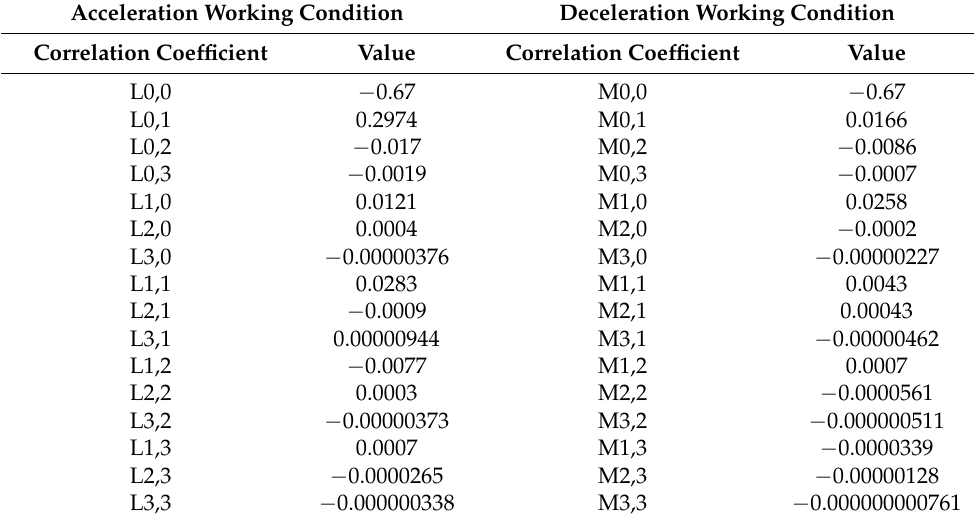
Table 4. Parameter values of the VT-Micro